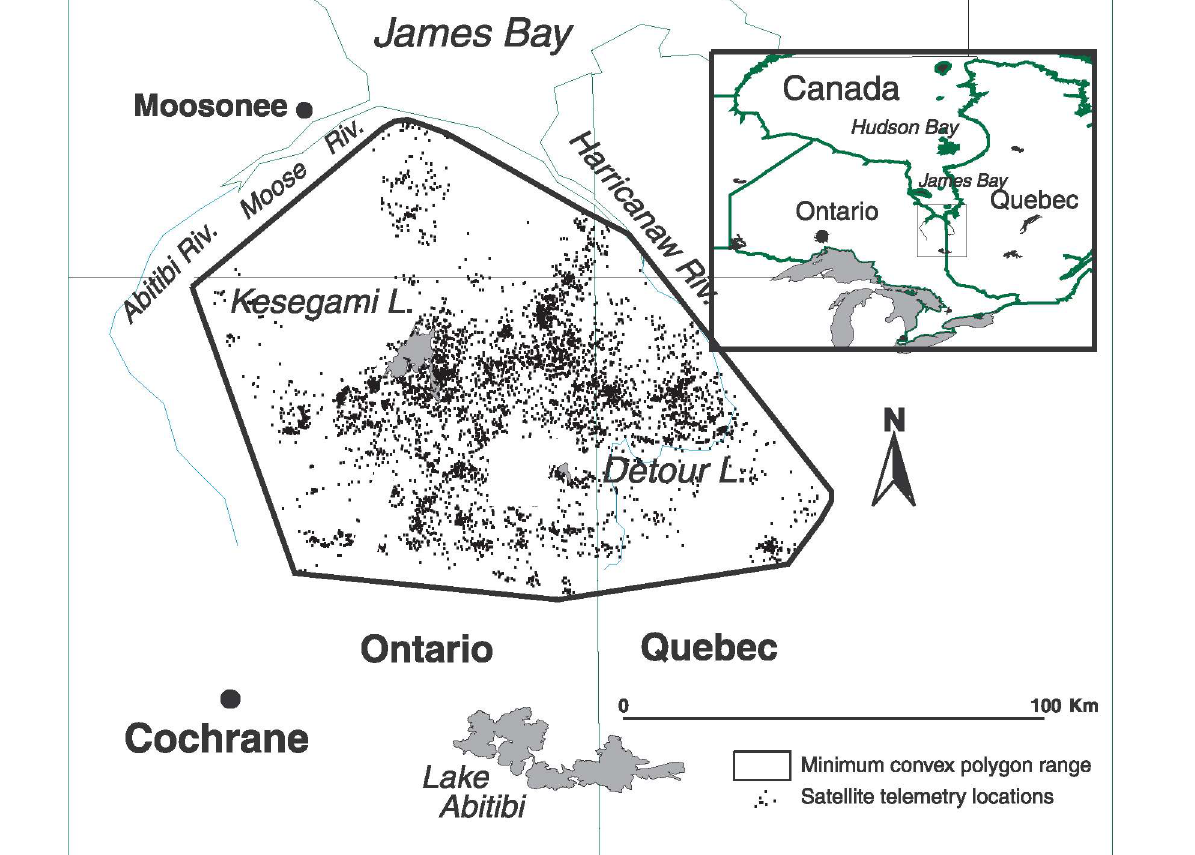
Fig. 1. Collared female woodland caribou distribution south of James Bay, Ontario, Canada,